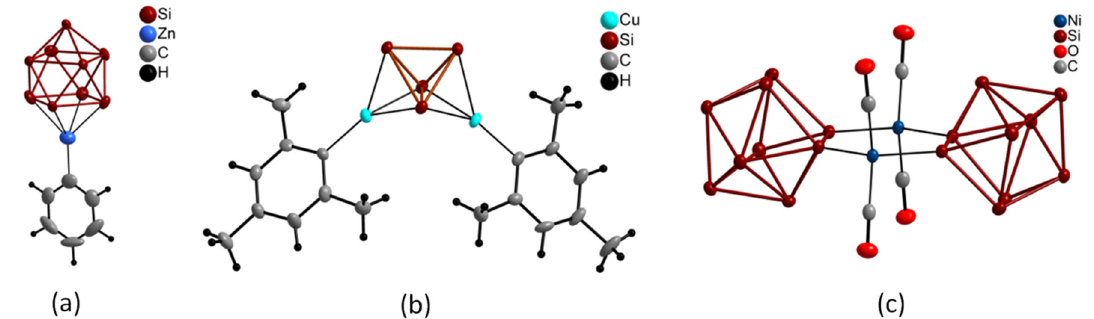
Figure 1. Silicon cage anions in transition metal complexes: ( a ) [Si 9 ZnPh] 3 − [15]; ( b ) [(MesCu) 2 Si 4 ] 4 − [16]; ( c ) [{Ni(CO) 2 } 2 (µ-Si 9 ) 2 ] 8 −